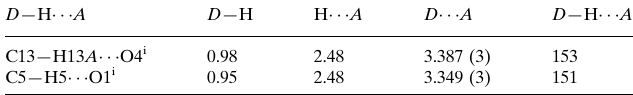
Hydrogen-bond geometry (A˚ , (cid:2)